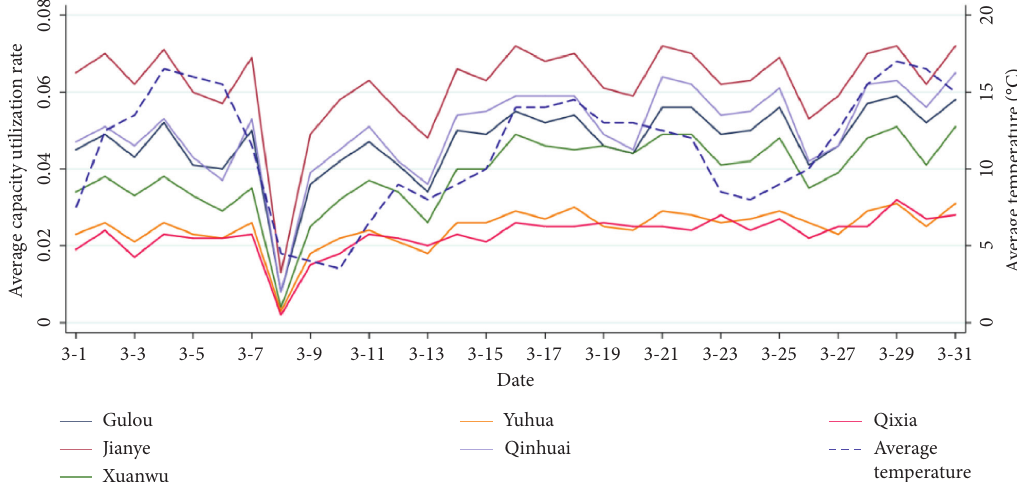
Figure 4: Daily variation tendency of capacity utilization rate of bicycle-sharing. Table 5: Correlation analysis between the capacity utilization rate and factors. Correlative factor Average temperature The number of rental stations Population density